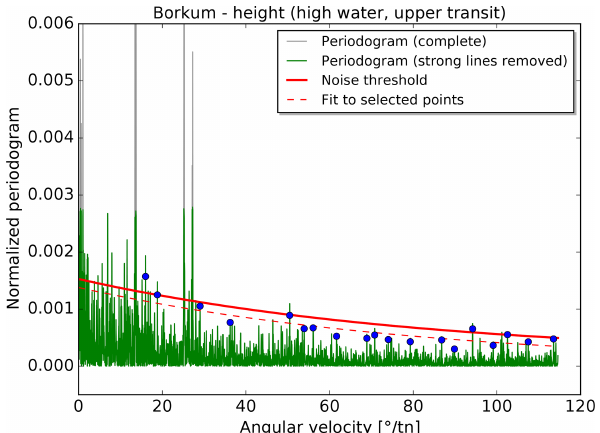
Figure 5. Same as Fig. 4 but for the heights at tide gauge Borkum,